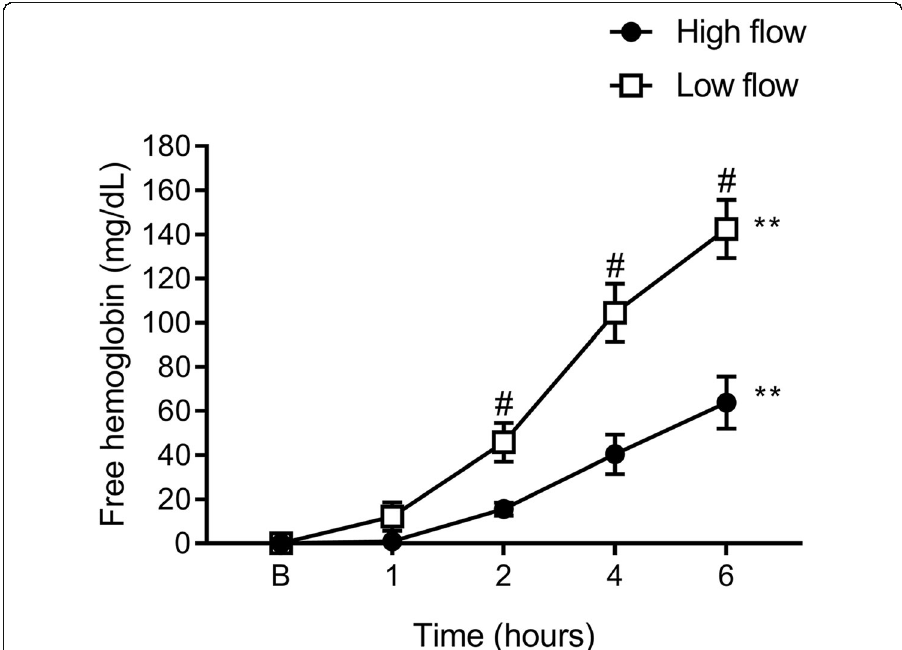
Fig. 2 Time-dependent haemolysis with different blood flow regimens. Haemolysis levels were significantly increased over time from baseline to 6 h with both high and low-flow rates. Significant differences also were evident between high- and low-flow at 2, 4 and 6 h. Data are presented as mean ± SEM. ** p < 0.01 from baseline to 6 h; # p < 0.05 high vs. low flow. n = 5 high flow, n = 4 low